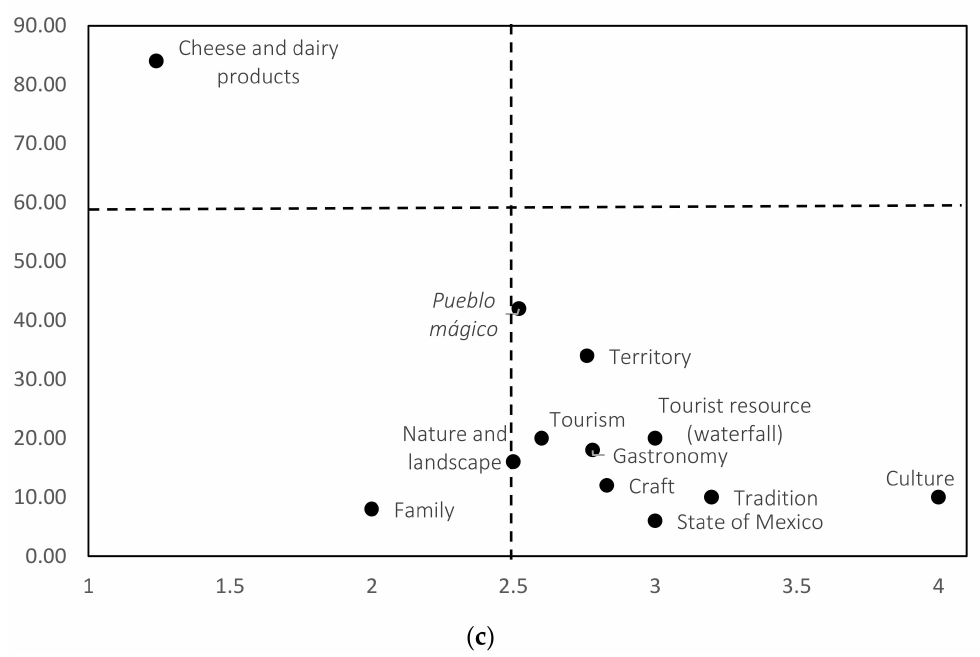
Figure 1. Prototype maps of the three study samples. ( a ) Paper ballots. ( b ) Online survey. ( c ) Ran- dom